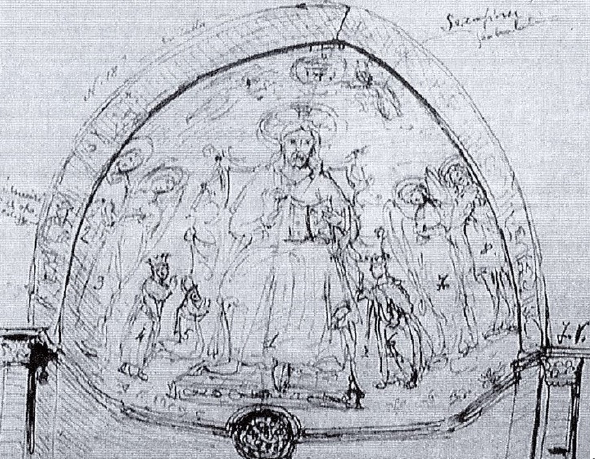
Figure 5. Graphic survey of the mosaics of the central apse of the Cathedral of Messina after the 1943 fire. Palermo, Biblioteca Comunale, Valenti Photographic Archives. Reproduced with permission of the Licensor. Detail of the image published in [53] (Figure 9).